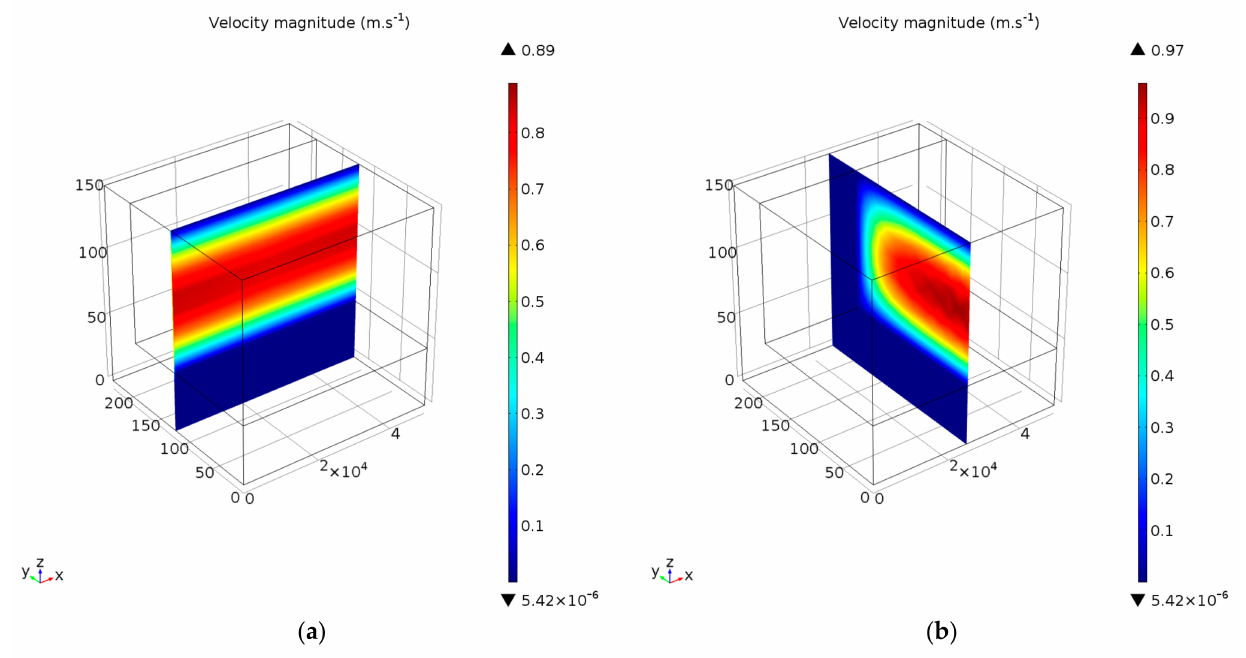
Figure 8. Velocity profiles in ( a ) axial, and ( b ) cross-sectional microchannel planes (axes in µ m). Reaction conditions: temperature 120 ◦ C and space velocity 65.2 NL g cat − 1 h − 1